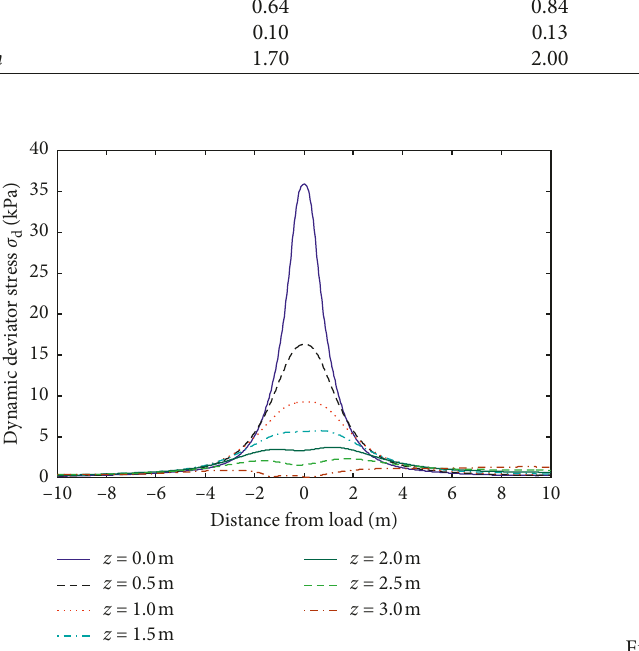
Figure 3: Distributions of the dynamic deviator stress σ the axle load.